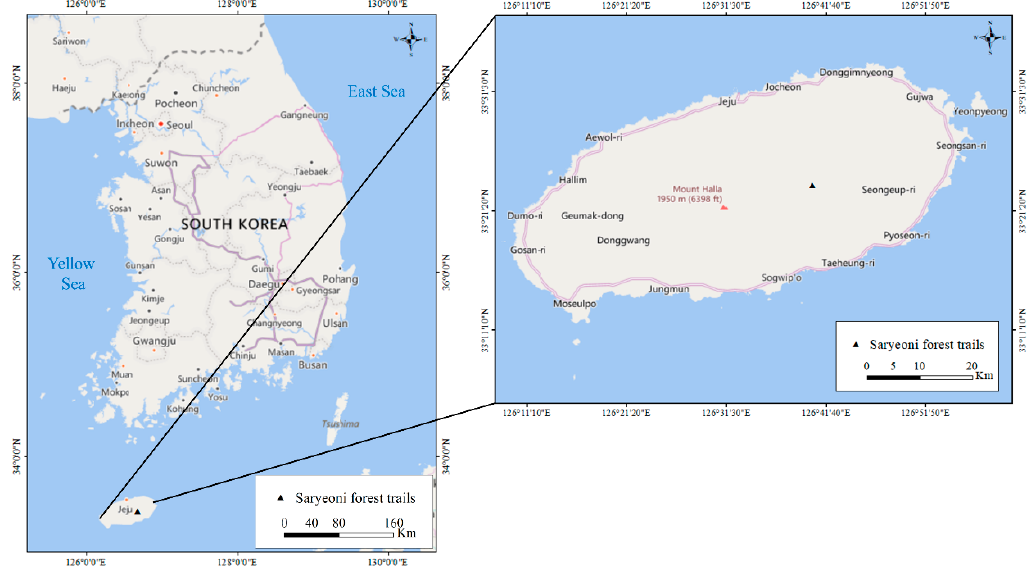
Figure 1. Location of study area in Jeju Island, South Korea.